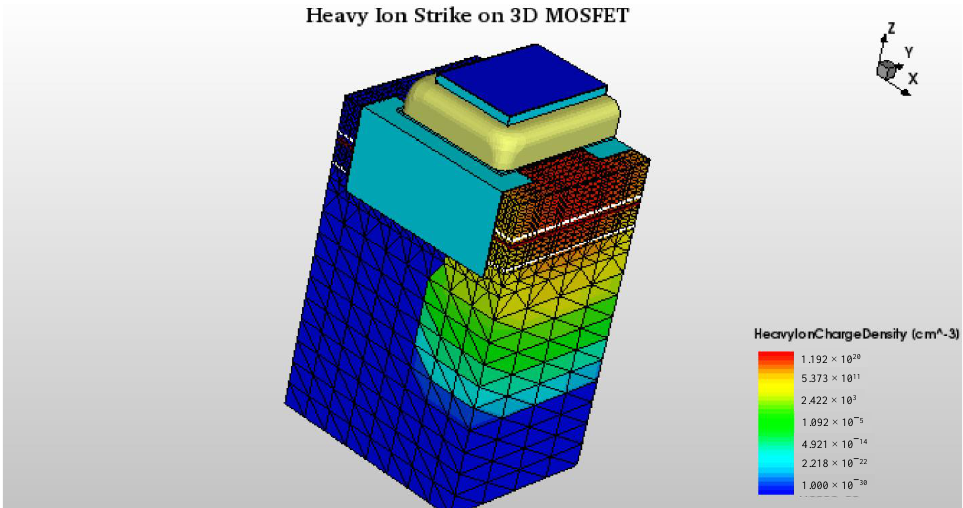
Figure 1. A heavy ion striking the drain of NMOS and inducing charge generation.